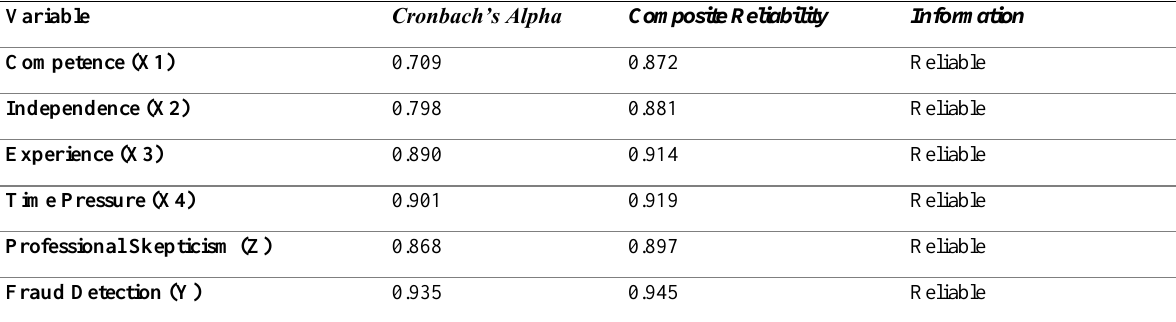
Table 3: Reliability Test Result